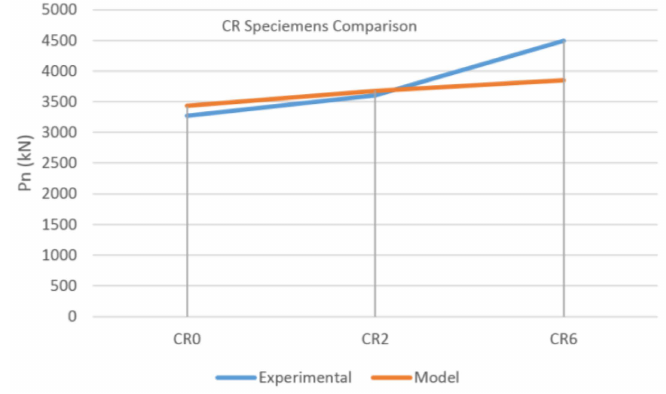
Figure 21. Analytic vs. experimental capacity comparisons for rectangular specimens.